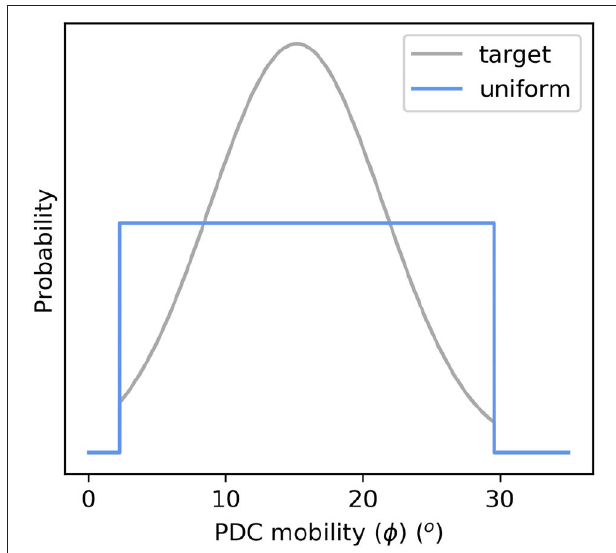
FIGURE 7 | The truncated Gaussian “target” PDF (gray) showing the expected distribution of PDC mobilities ( φ ) at Aluto in nature. The uniform PDF (blue) was used to sample the φ parameter during energy cone simulation. In importance sampling, the target PDF was used to weight the simulation